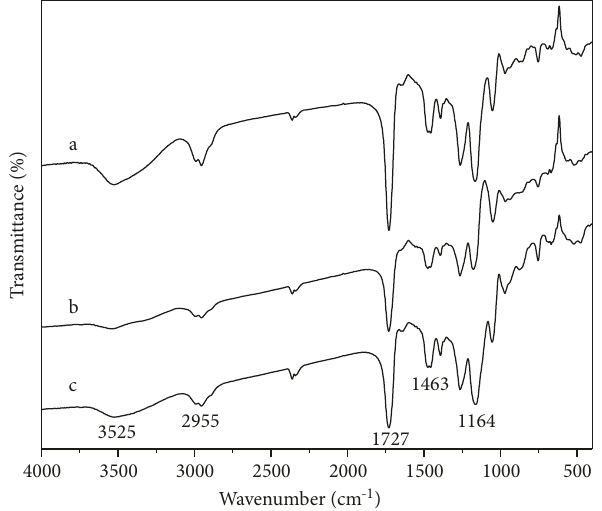
Figure 3: FT-IR spectra of P GMA / EDMA (a), P GMA / EDMA @MPS (b), @MIPs and P GMA - EDMA